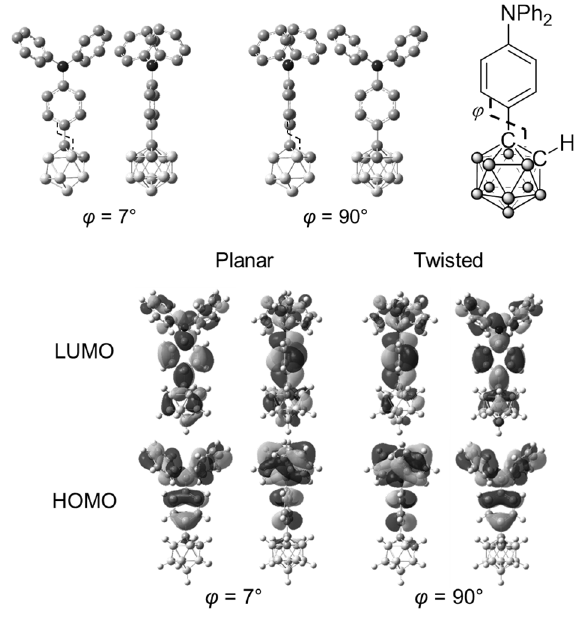
Figure 5. Optimized structures and calculated molecular orbitals of 1B in the ground state.